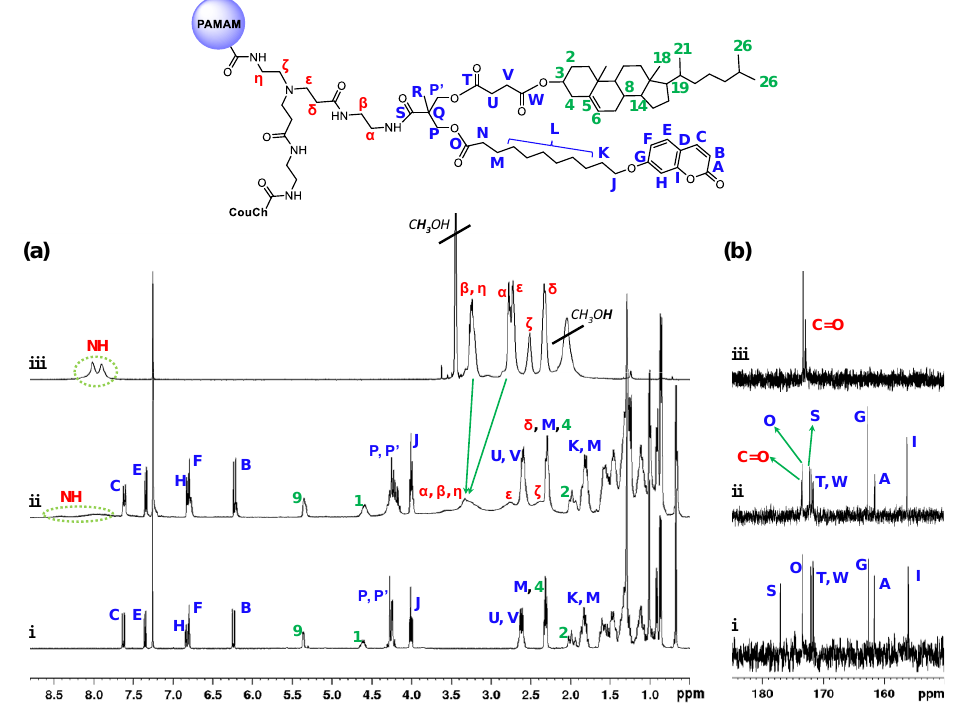
Figure 1. ( a ) 1 H NMR and ( b ) 13 C NMR spectra in CDCl 3 at 25° C of: (i) Ac–ChCou , (ii) covalent